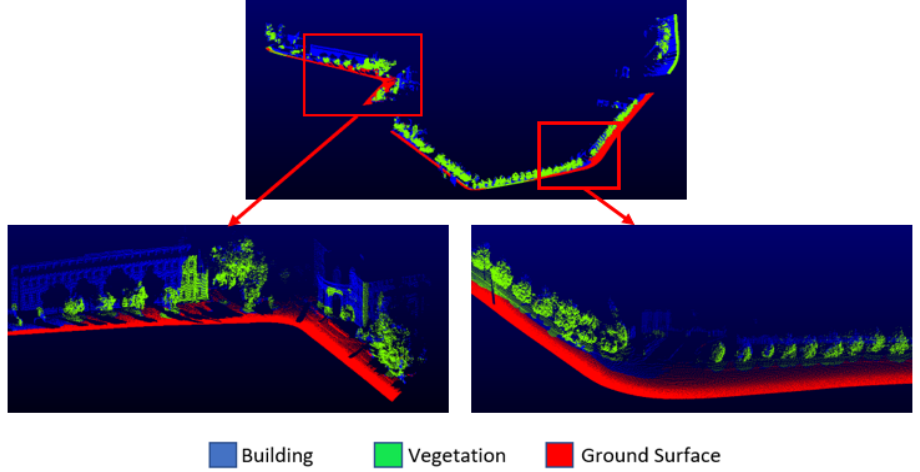
ISPRS Int. J. Geo-Inf. 2021 , 10 , 187 Figure 10. Classified point cloud with the highest accuracy in the Oakland3D (97.30% with LDA in R 1 ).